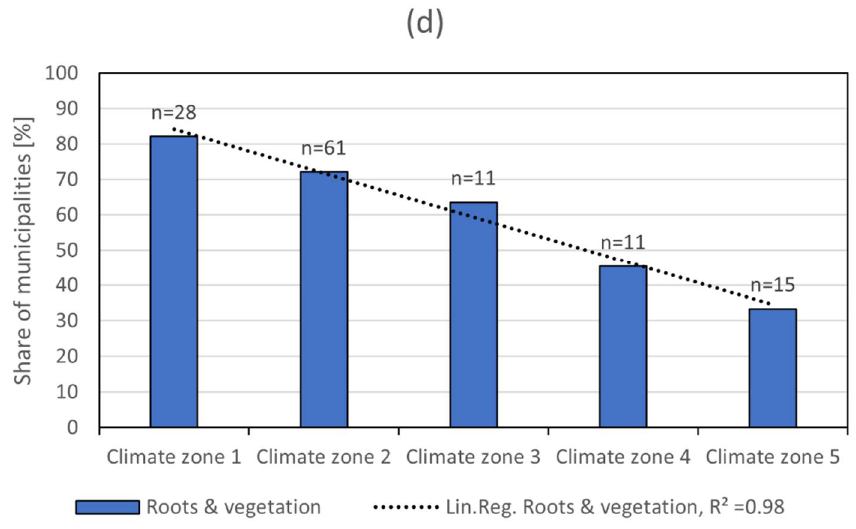
Figure 8. Problematic frequency of distress causes on the municipal cycle path networks with respect to climate zones for ( a ) frost heave, ( b ) freeze and thaw cycles, ( c ) poor material/poor execution, and ( d ) roots and vegetation.